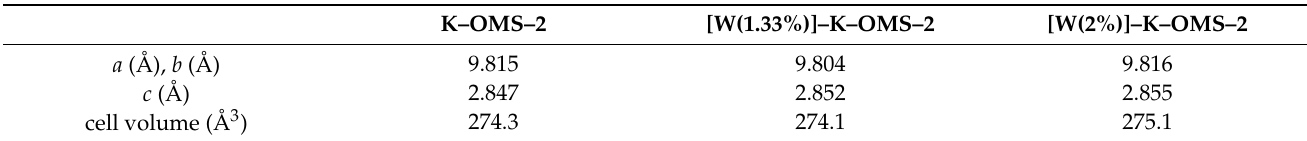
Table 5. Cell parameters obtained from Rietveld refinement of undoped (K–OMS–2) and [W]–K–OMS–2-doped materials. Data extracted from